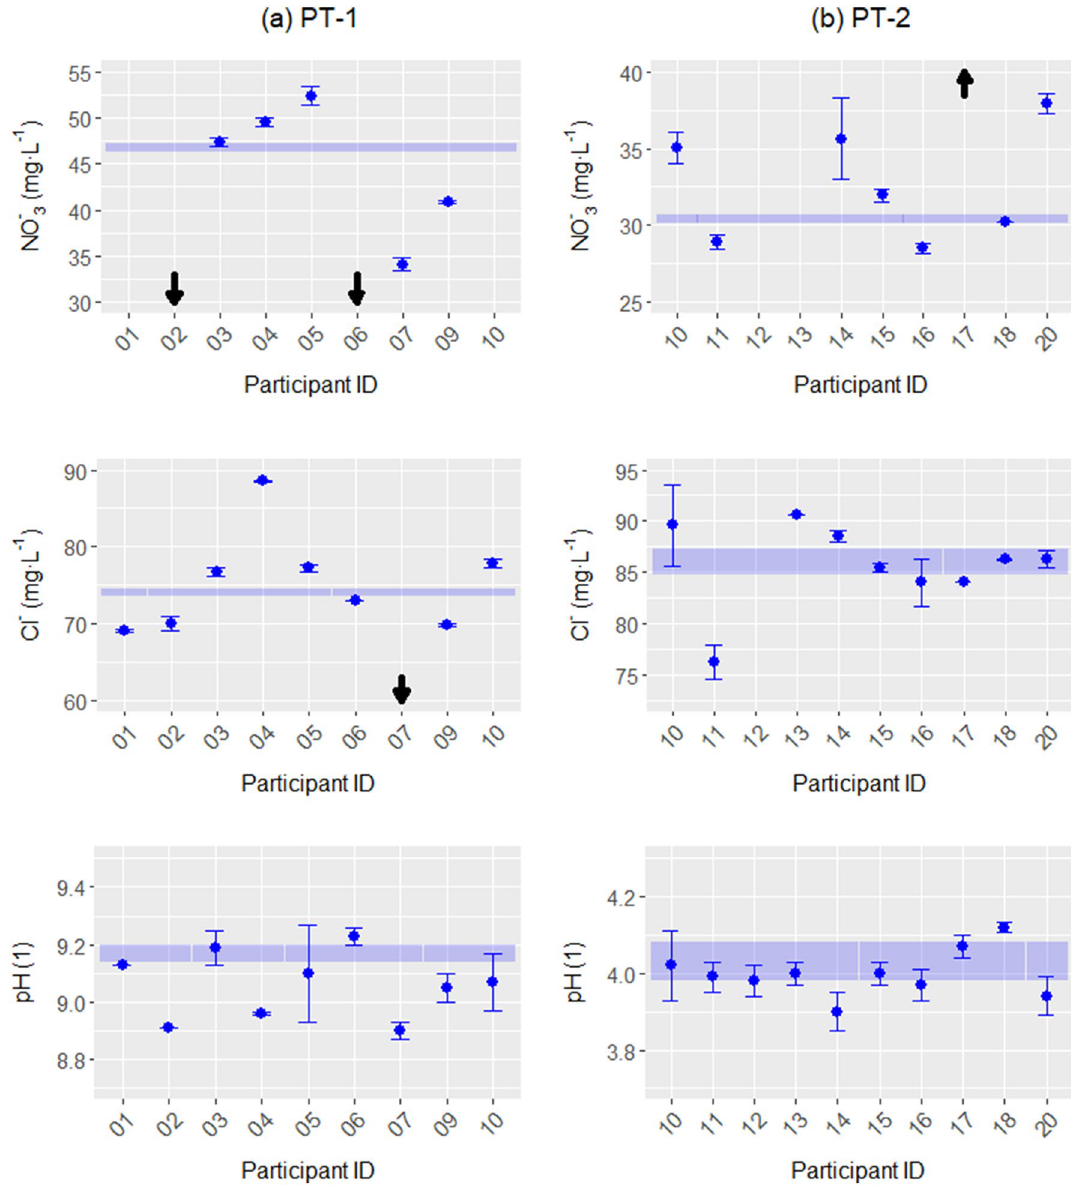
represent values outside axis